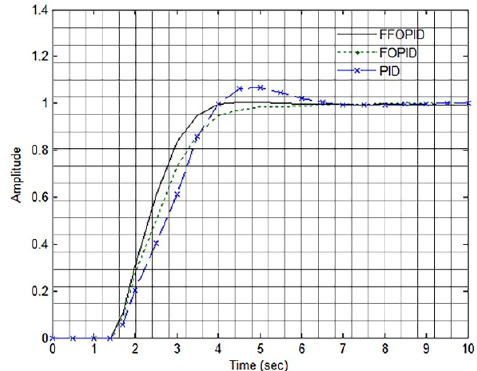
Figure 5. Step response of various controllers.